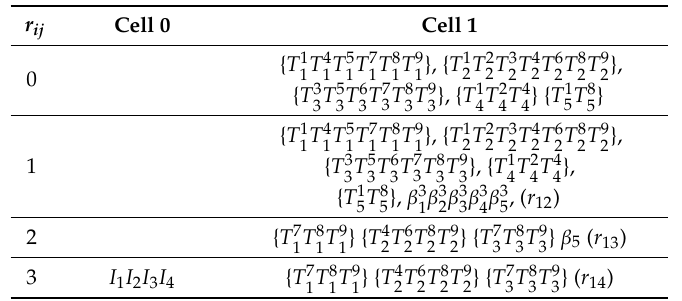
Table 3. Generation of frequent 1-patterns.